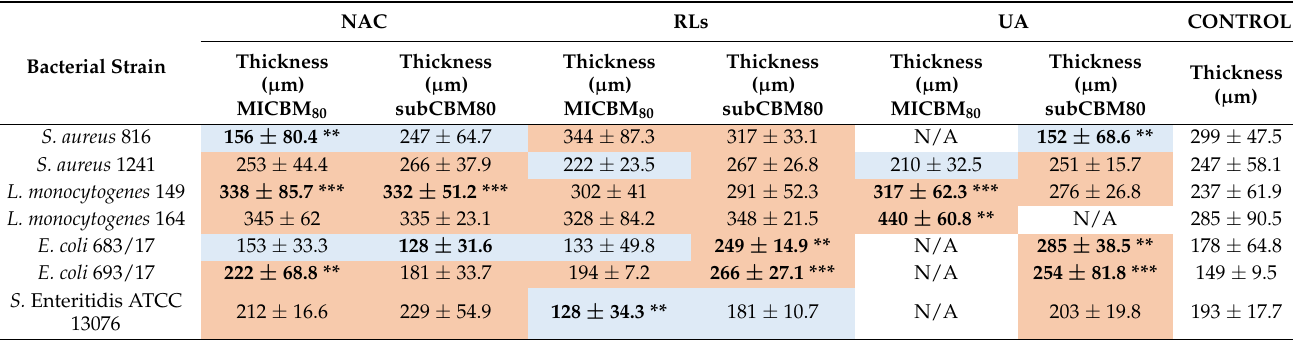
Table 4. Biofilm Removal: Total biofilm thickness for individual organisms with the respective treatment types ( N -Acetyl- L -cysteine (NAC), rhamnolipids (RLs), and usnic acid (UA)) following 20 h of exposure. Data represent the mean and standard deviation of at least four independent technical replicates.